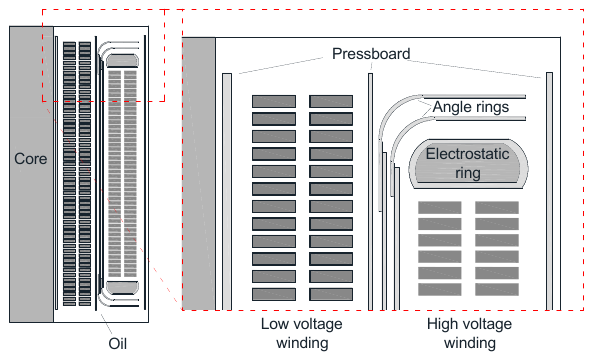
Figure 5. Axisymmetric model of transformer inner insulation structure.